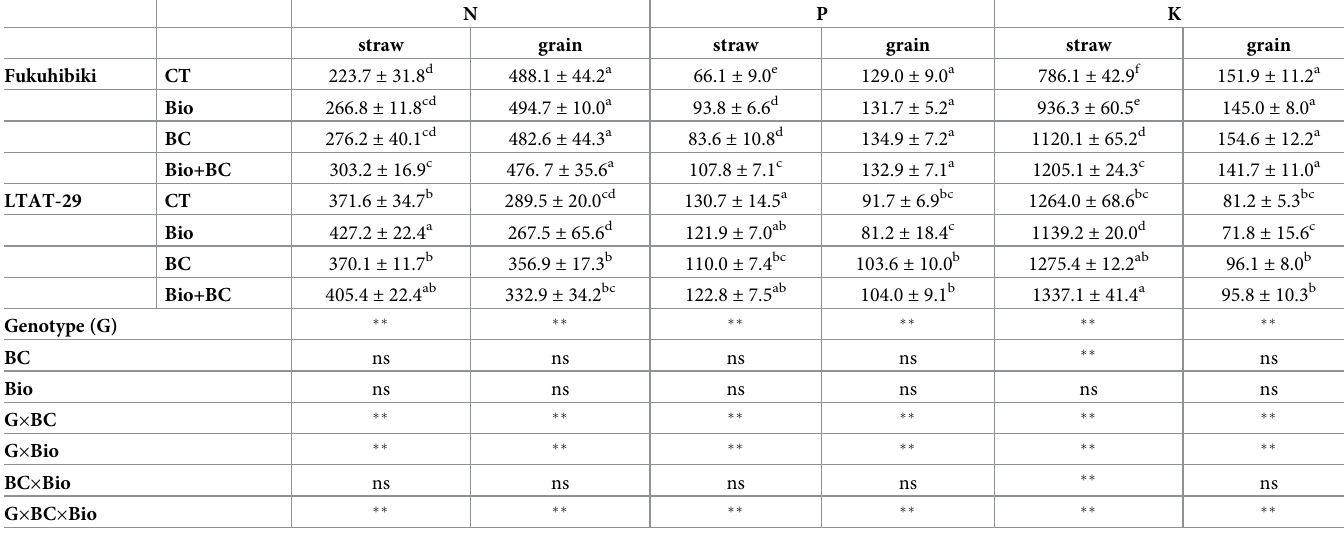
Table 7. N, P, and K uptake (mg plant − 1 ) in two forage rice in response to different